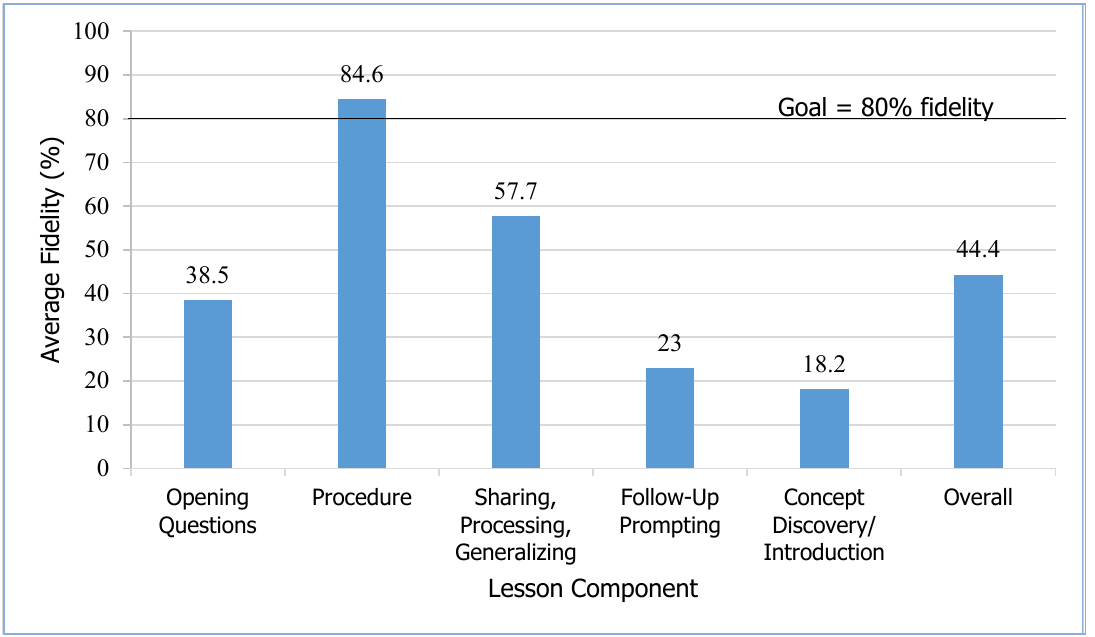
Figure 2. Average Fidelity to the Discovering Healthy Choices (Linnell et al., 2015) Curriculum by Lesson Component in the 1 st